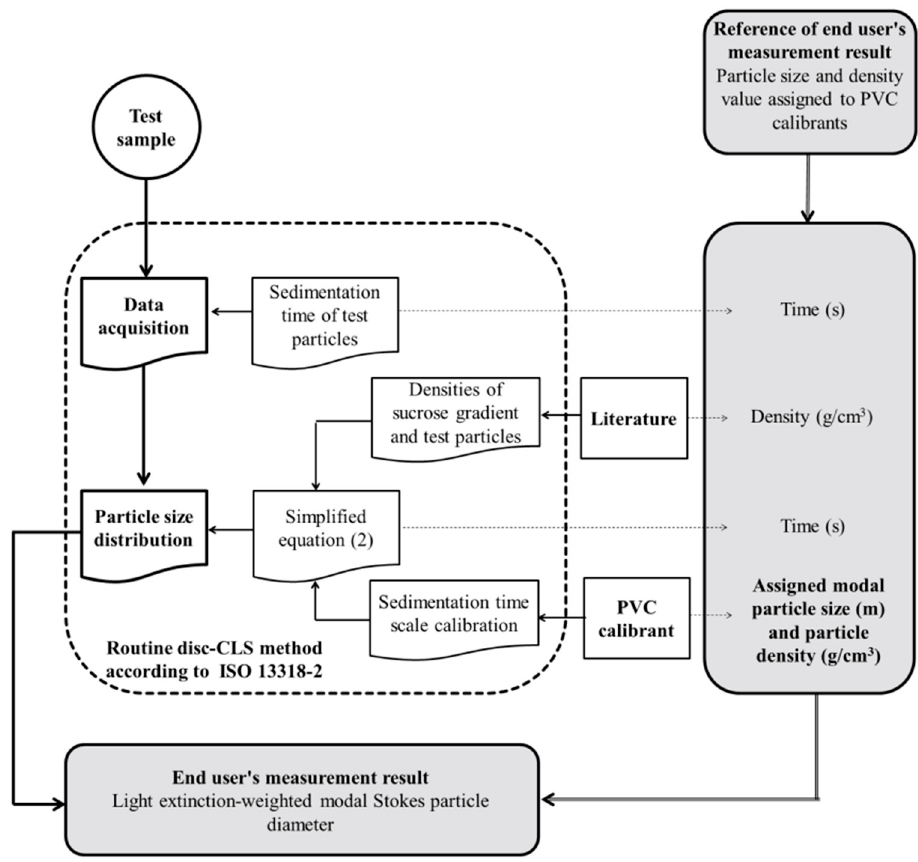
Figure 1. Metrological traceability network linking a particle size measurement result of a test sample obtained by the routine disc-CLS method (after calibration with PVC reference particles) to the particle size and particle density values assigned to the PVC calibration material. In this network, and in other schemes further discussed in this manuscript, the dotted rounded groups indicate measurement procedures, while the square boxes represent tools, reference materials and accepted literature/reference values. The different input quantities of the measurement functions are grouped in rounded shaded boxes with solid borders.